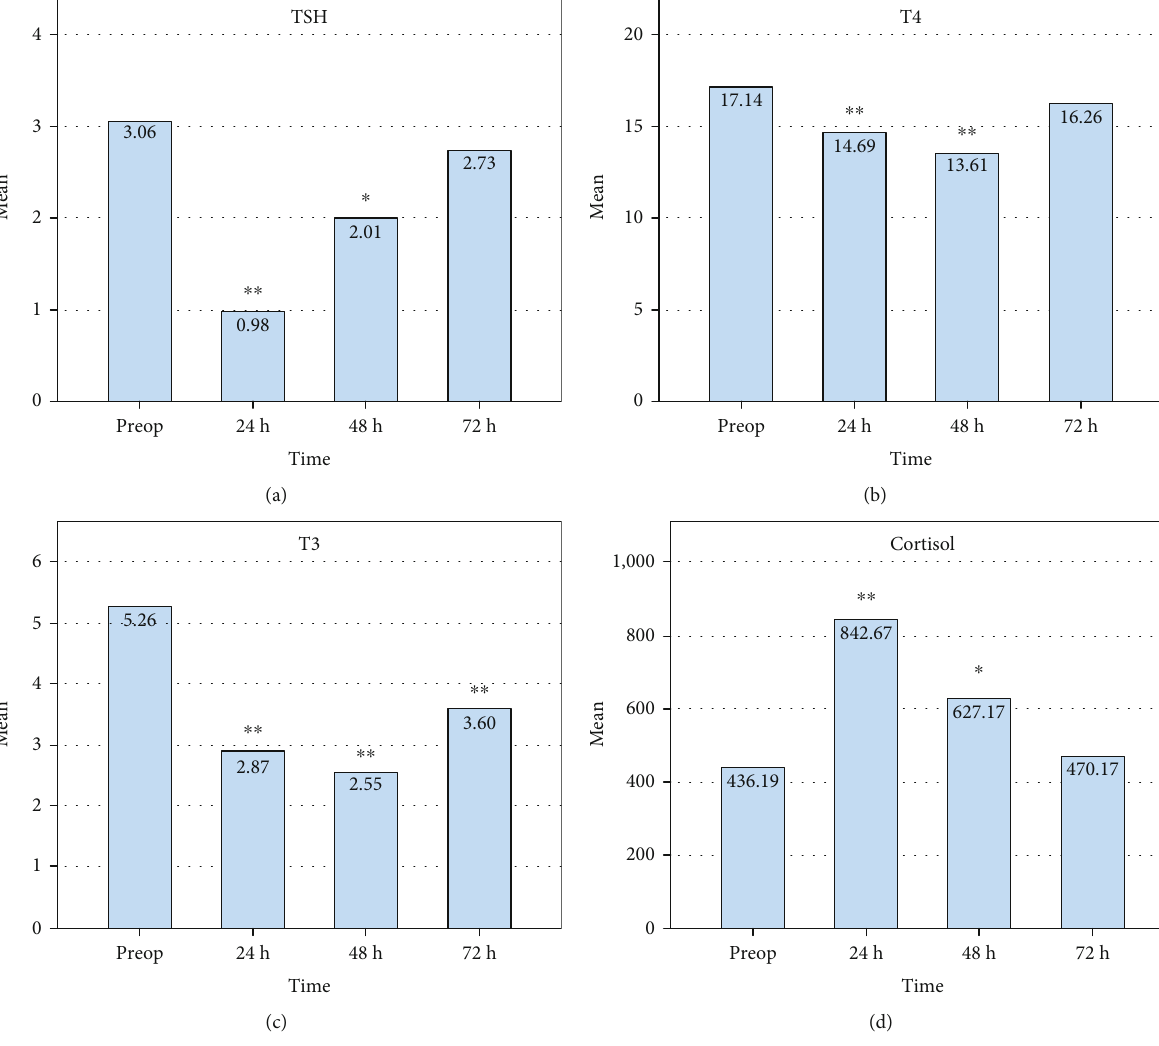
Figure 1: Changes in thyroid function and cortisol level in the 72-hour postoperative period. Bars represent the mean levels of (a) TSH, (b) fT4, (c) fT3, and (d) cortisol in the preoperative period and 24, 48, and 72 hours postop. Signi fi cance levels are calculated with reference to the levels observed in the preoperative period: ∗∗ p < 0 : 01 ; ∗ p < 0 : 05